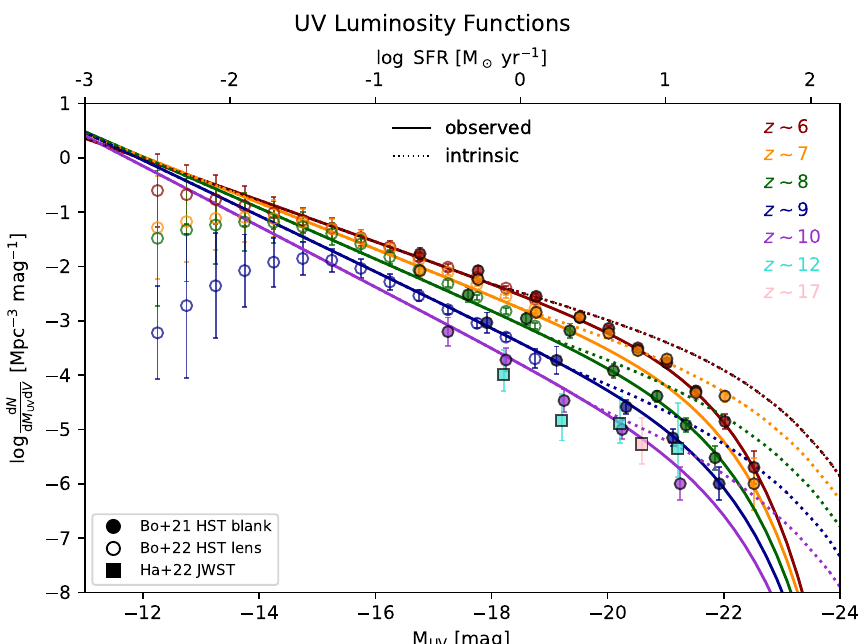
Figure 1. The UV luminosity functions at redshifts z ∼ 6 (red), 7 (orange), 8 (green), 9 (blue), 10 (magenta), 12 (cyan) and 17 (pink). Data points are from [77,78] (filled circles), [79] (empty circles), and [80] (squares). Colored lines illustrate Schechter fits the blank-field measurements from [78]: solid lines refer to the observed luminosity functions, while dotted lines to the intrinsic ones, after correction for dust extinction via the UV continuum slope according to the procedure by